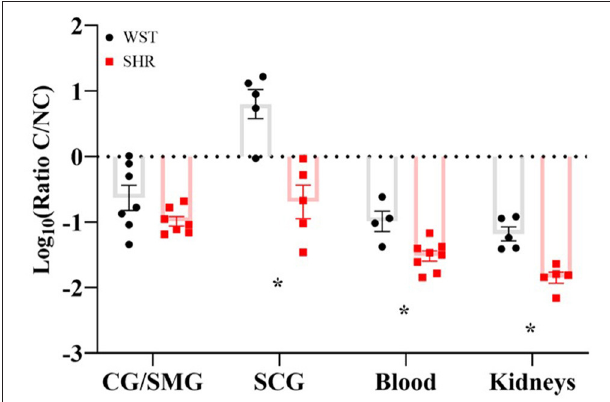
FIGURE 5 | Classical/non-classical monocyte-macrophage ratios in the coeliac/superior mesenteric ganglia (CG/SMG; Wistar: n = 7 samples, 2 rats per sample; SHR: n = 7 samples, 2-4 rats per sample), superior cervical ganglia (SCG; in both strains: n = 5 samples, 2 rats per sample), blood (Wistar n = 4 samples, SHR n = 8 samples, 1 rat per sample) and kidneys (both strains n = 5 samples, 1 rat per sample) of 3-week old Wistar rats and pre-SHRs. Data are expressed as mean ± SEM. * signifies p < 0.05 WST vs. SHR, Welch’s t-tests with q values determined by the two-stage set-up method of Benjamini, Krieger and Yekutieli.